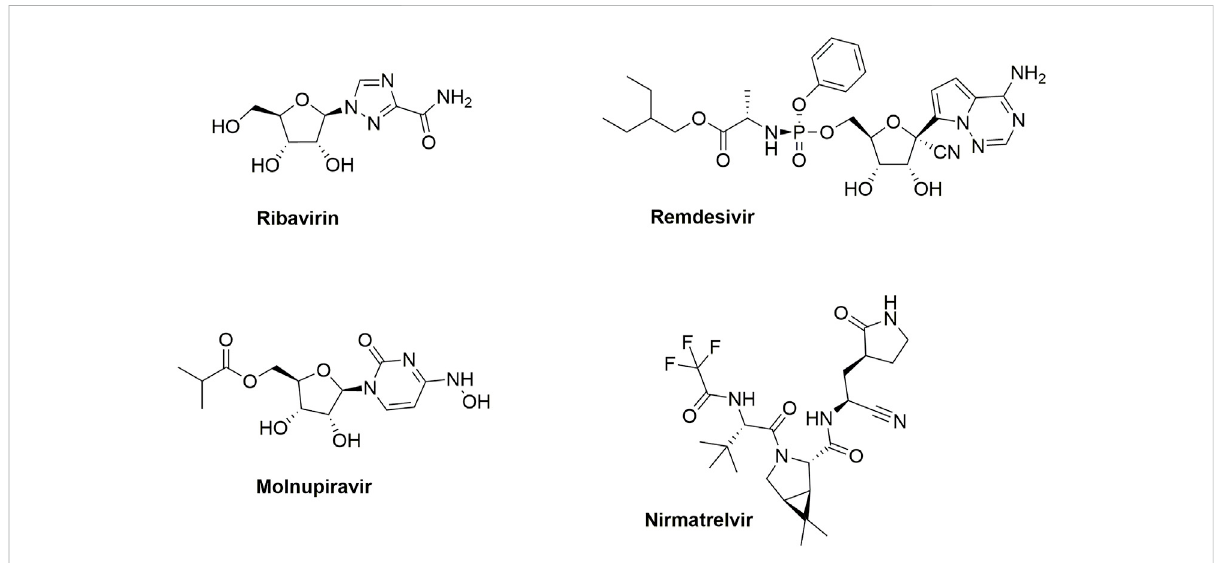
Marketed drugs for RSV and SARS-CoV-2